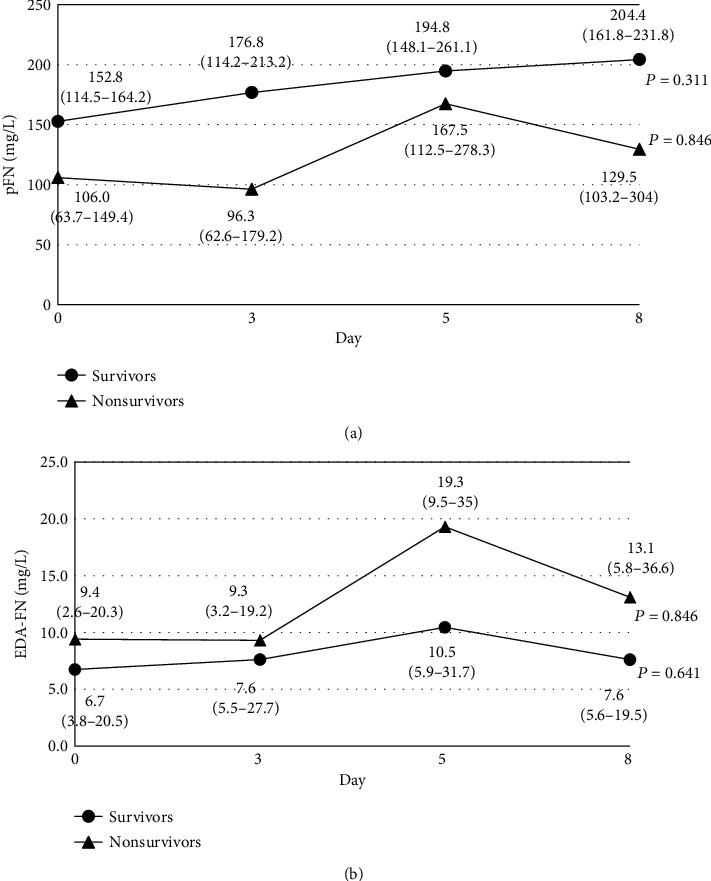
The time course of the changes in the pFN (a) and EDA-FN (b) levels in plasma of patients with sepsis. pFN and EDA-FN concentrations were determined by ELISA [25, 26]. The P values refer to the time course of the changes in pFN and EDA-FN levels in each group (Friedman repeated-measures ANOVA on ranks was applied to repeated measurements).